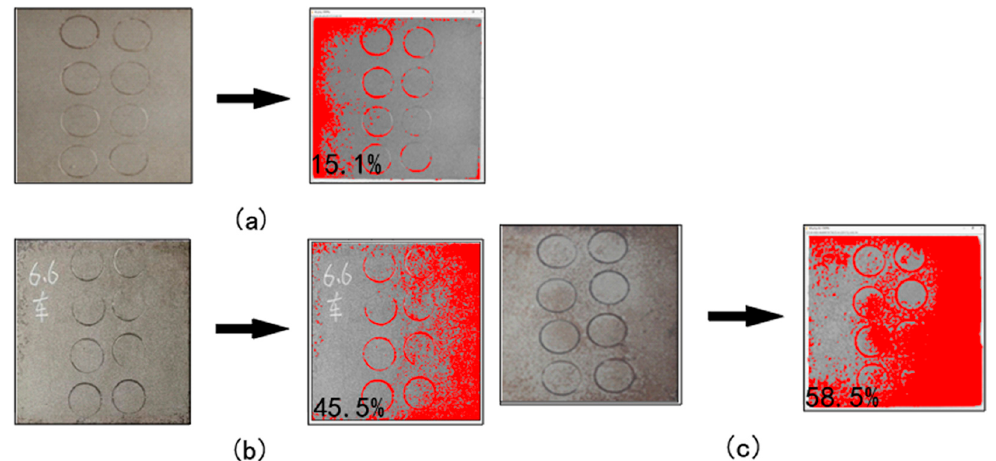
Figure 20. Corrosion of the no-zinc specimens with pavement air voids of ( a ) 2%, ( b ) 6%, the Chinese character “ 车 ” is the meaning of vehicle, and ( c ) 10% (Note: the red area represents the corrosion area, and the value is the proportion of the corrosion area).